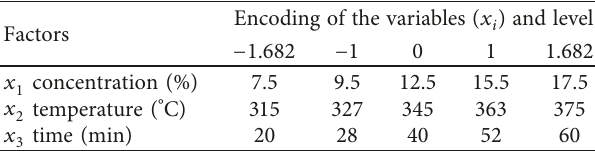
Table 2: Experimental factors and the levels.